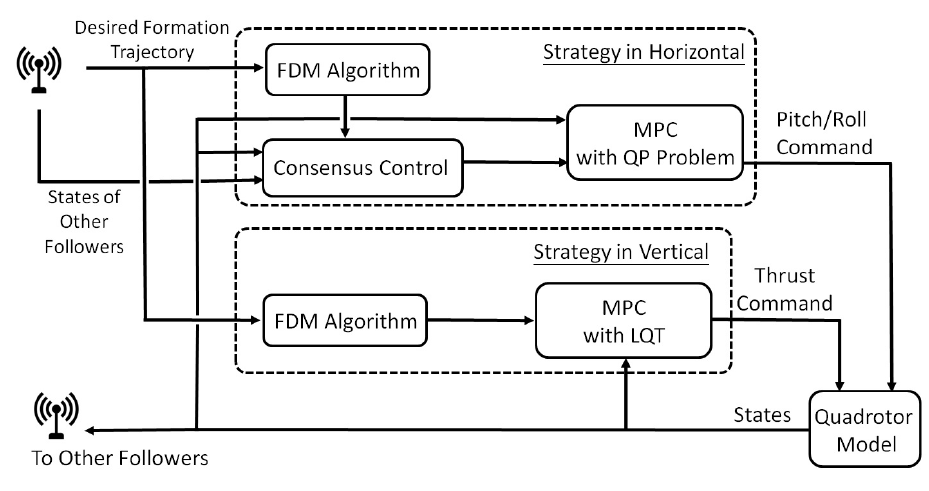
Figure 5. Follower’s control